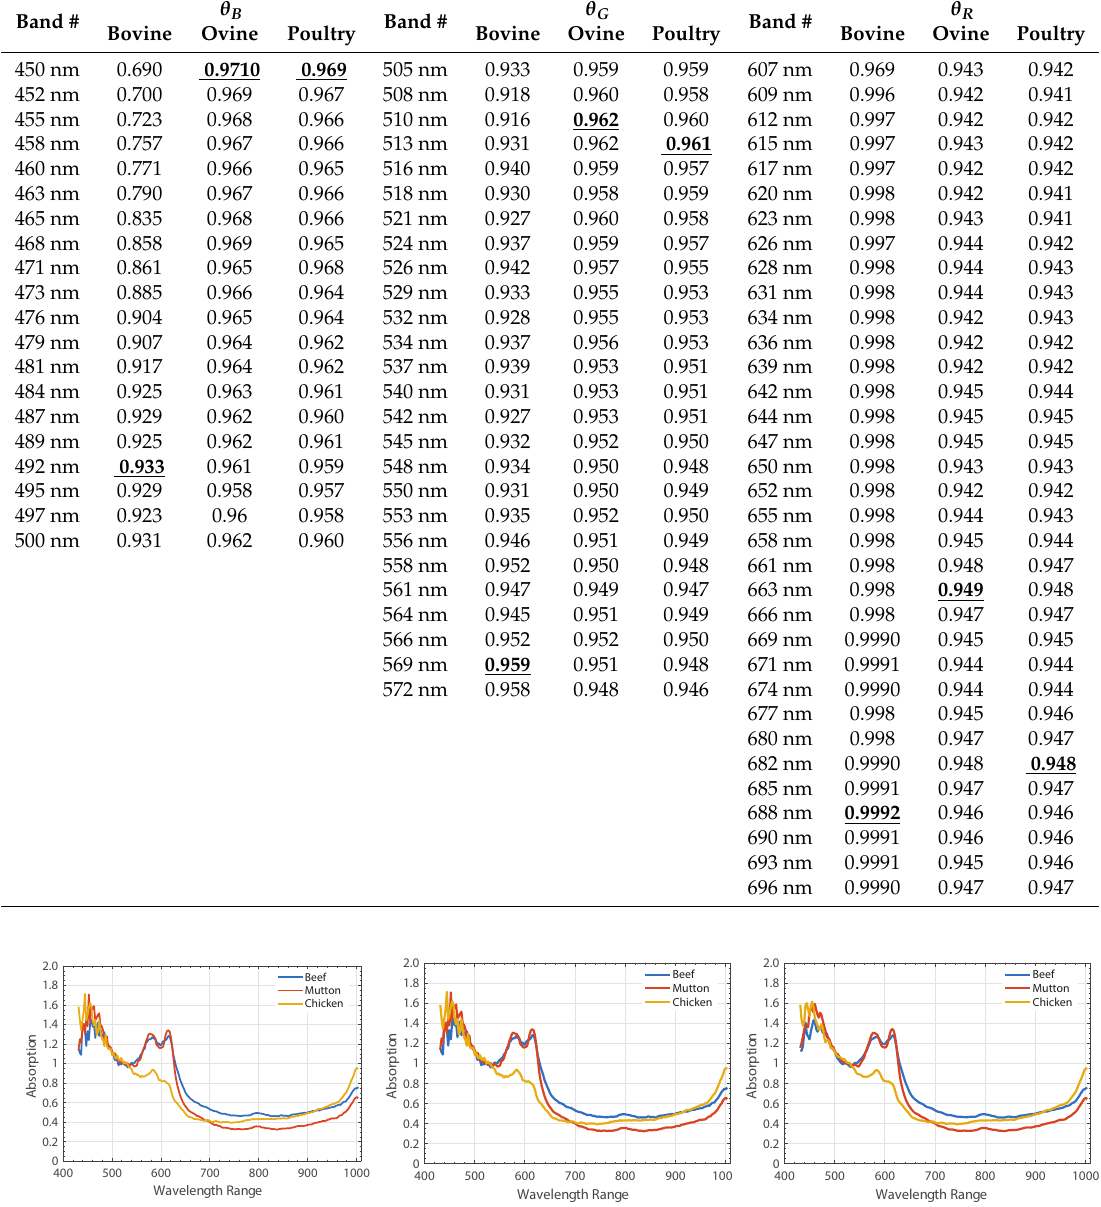
Table 2. The correlation values for true-color images. The underlined boldface values show the selected wavelengths (ñm) used to formulate true-color images .